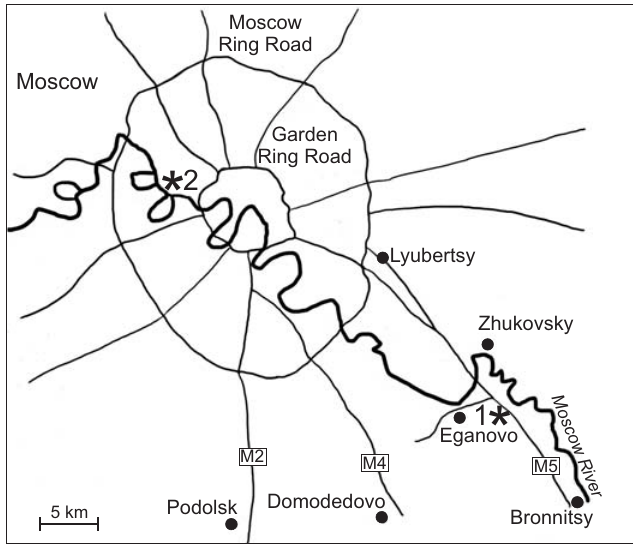
Fig. 1. Map of Moscow area with localities: 1, Eganovo (55°32’08.28” N; 38°03’10.47” E); 2, Mnevniki (55°46’4.12” N; 37°28’4.67” E).